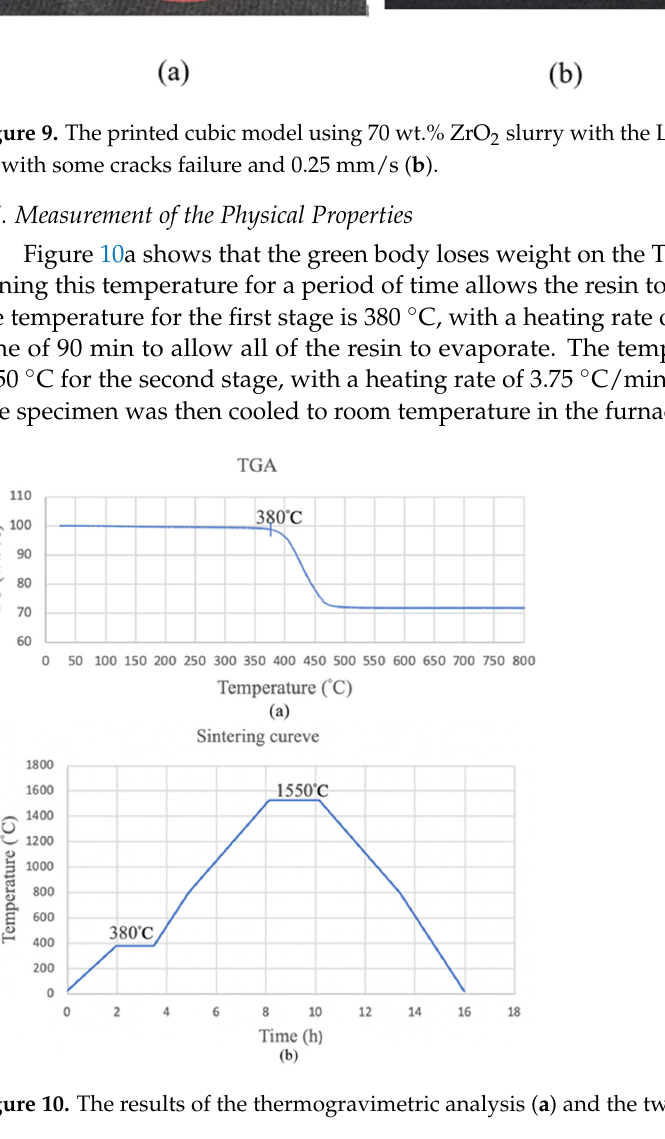
Figure 9. The printed cubic model using 70 wt.% ZrO 2 slurry with the LE box ascending at 0.4 mm/s ( a ) with some cracks failure and 0.25 mm/s ( b ).